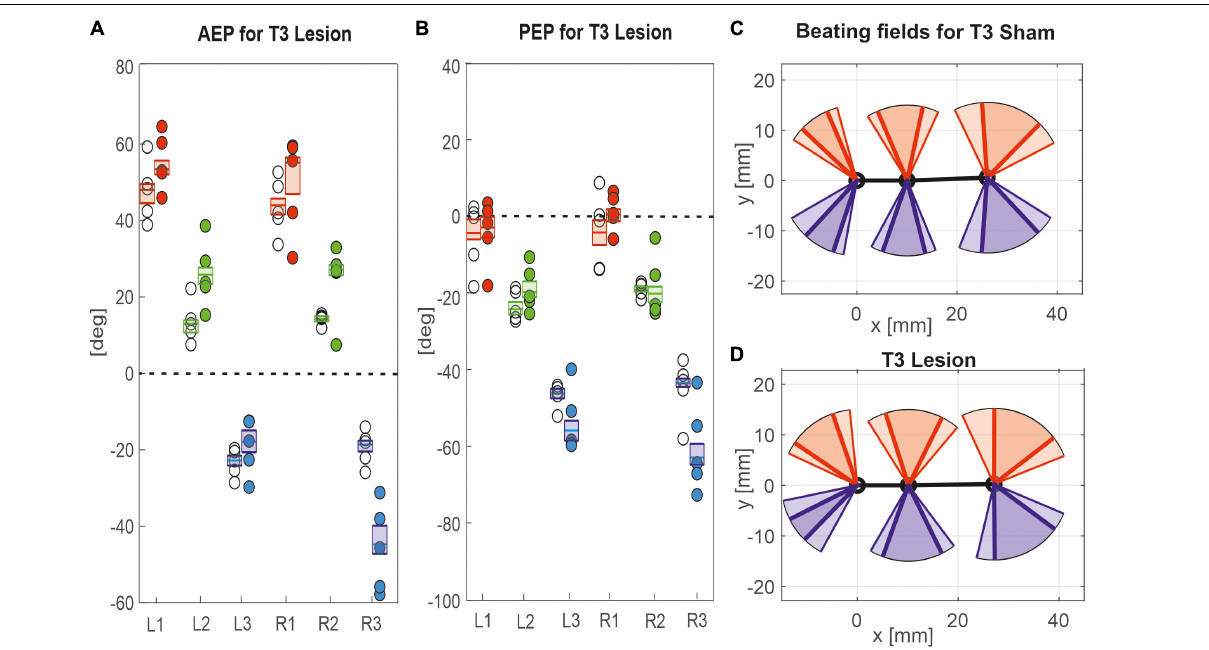
The statistical significance and direction of the effect (arrows) as well as the effect size (numbers) are shown for local changes in single leg step cycles and bilateral leg pairs of lesioned and sham-operated animals. Same details as in Table 1 .